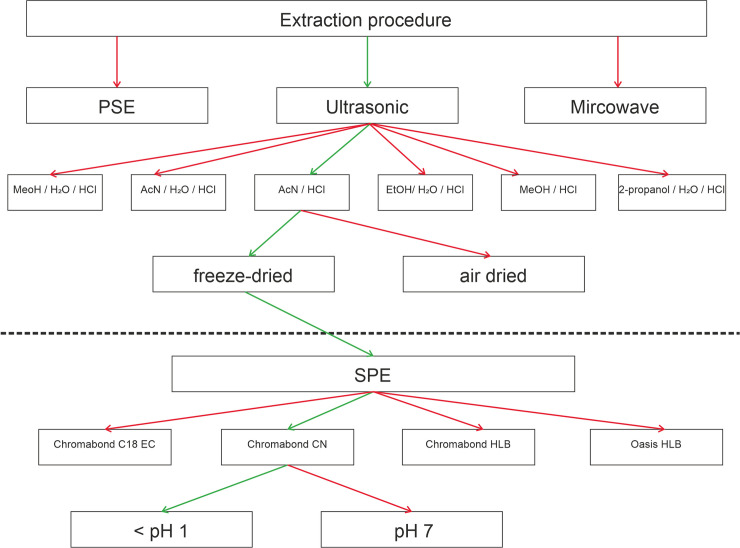
Schematic overview of the development of the extraction method.Green arrows indicate the chosen optimum procedure, red arrows represent dead ends with suboptimal results that were not further followed. The initial method development was performed for soil samples, and was subsequently also applied to sewage sludge samples.